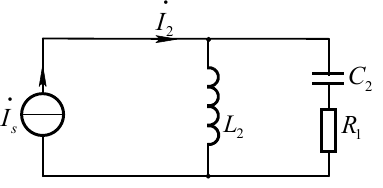
Figure 6. Receiving side resonance circuit diagram. The Thevenin equivalent transformation of the receiving side resonant circuit can be obtained, as shown in Figure 7.